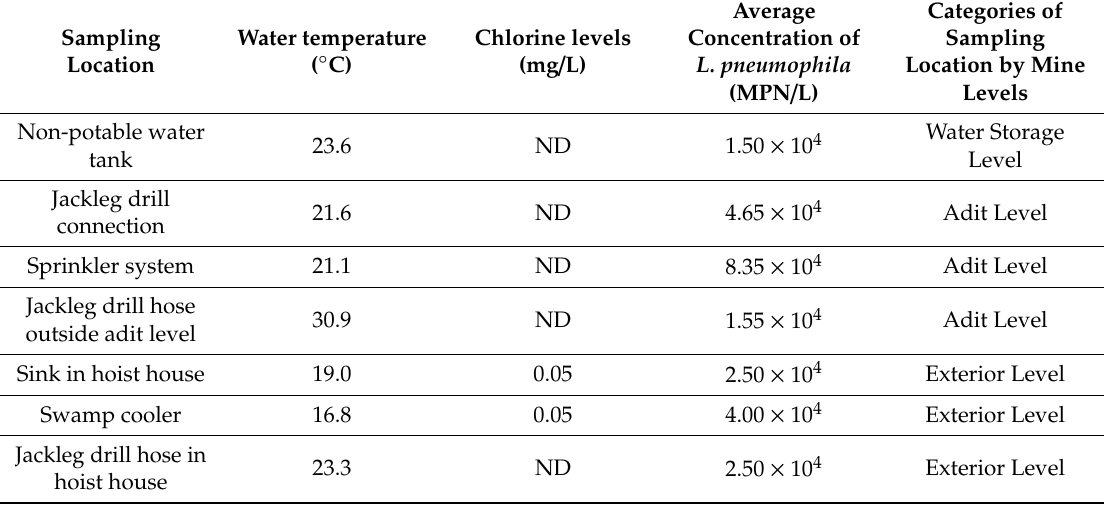
Table 2. Water quality measurements and the concentration of L. pneumophila in non-potable water sources.